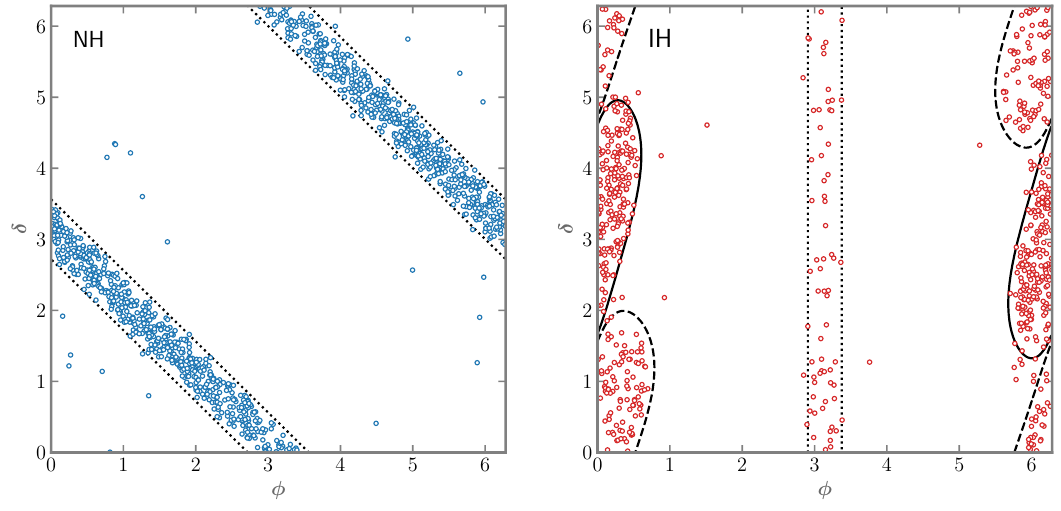
Figure 15 . Points from the scan at ∆ M/M = 10 − 2 for NH (left) and IH (right). The black dotted lines enclose the regions where (cid:15) 0 . 01 (NH), and (cid:15) 0 . 05 (IH), while the dashed lines enclose e ≤ e ≤ the region (cid:15) 0 . 03 and the solid that corresponding to (cid:15) 0 . 03 µ ≤ τ ≤